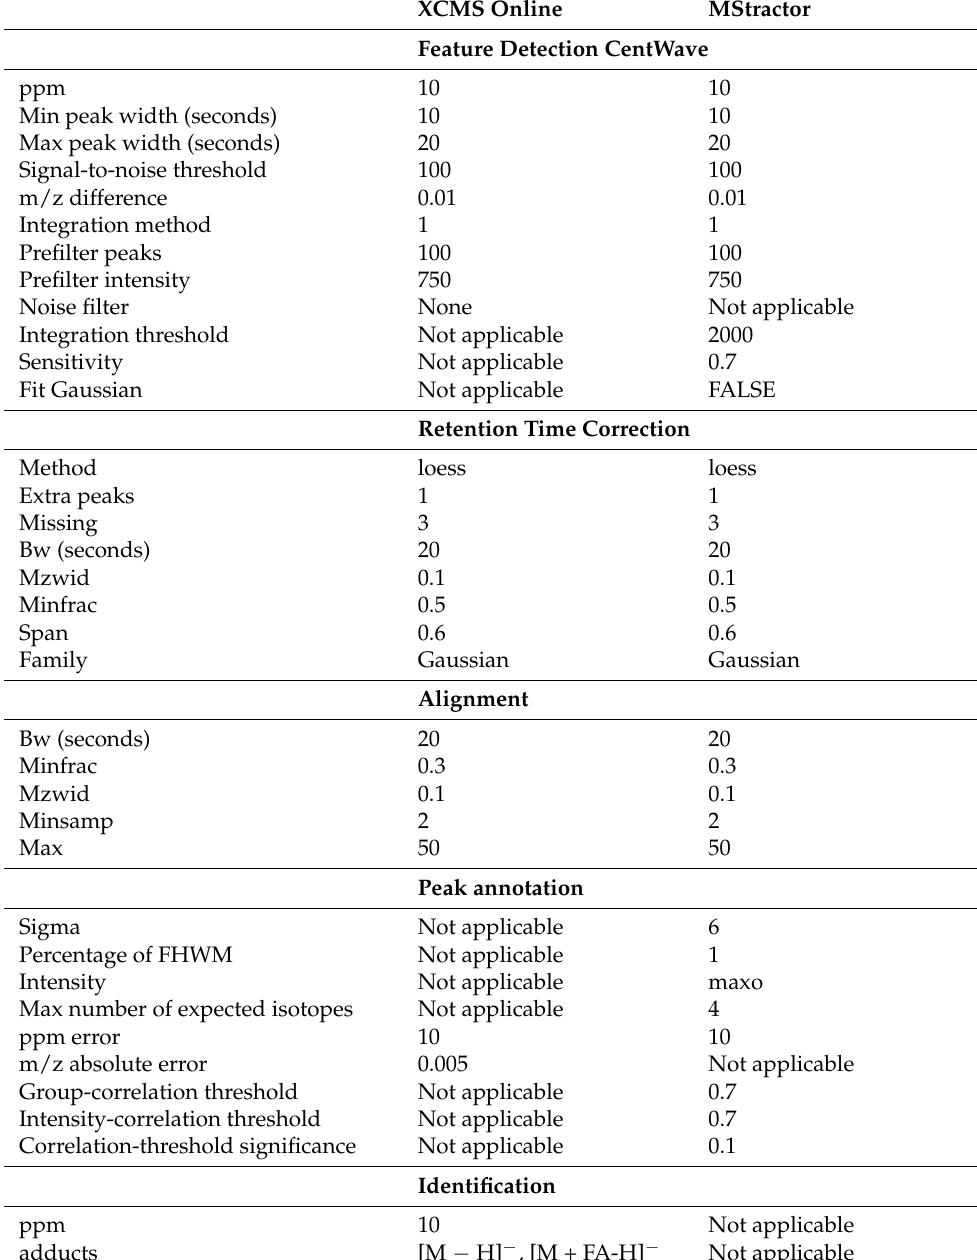
Table 1. Parameters used for XCMS Online and